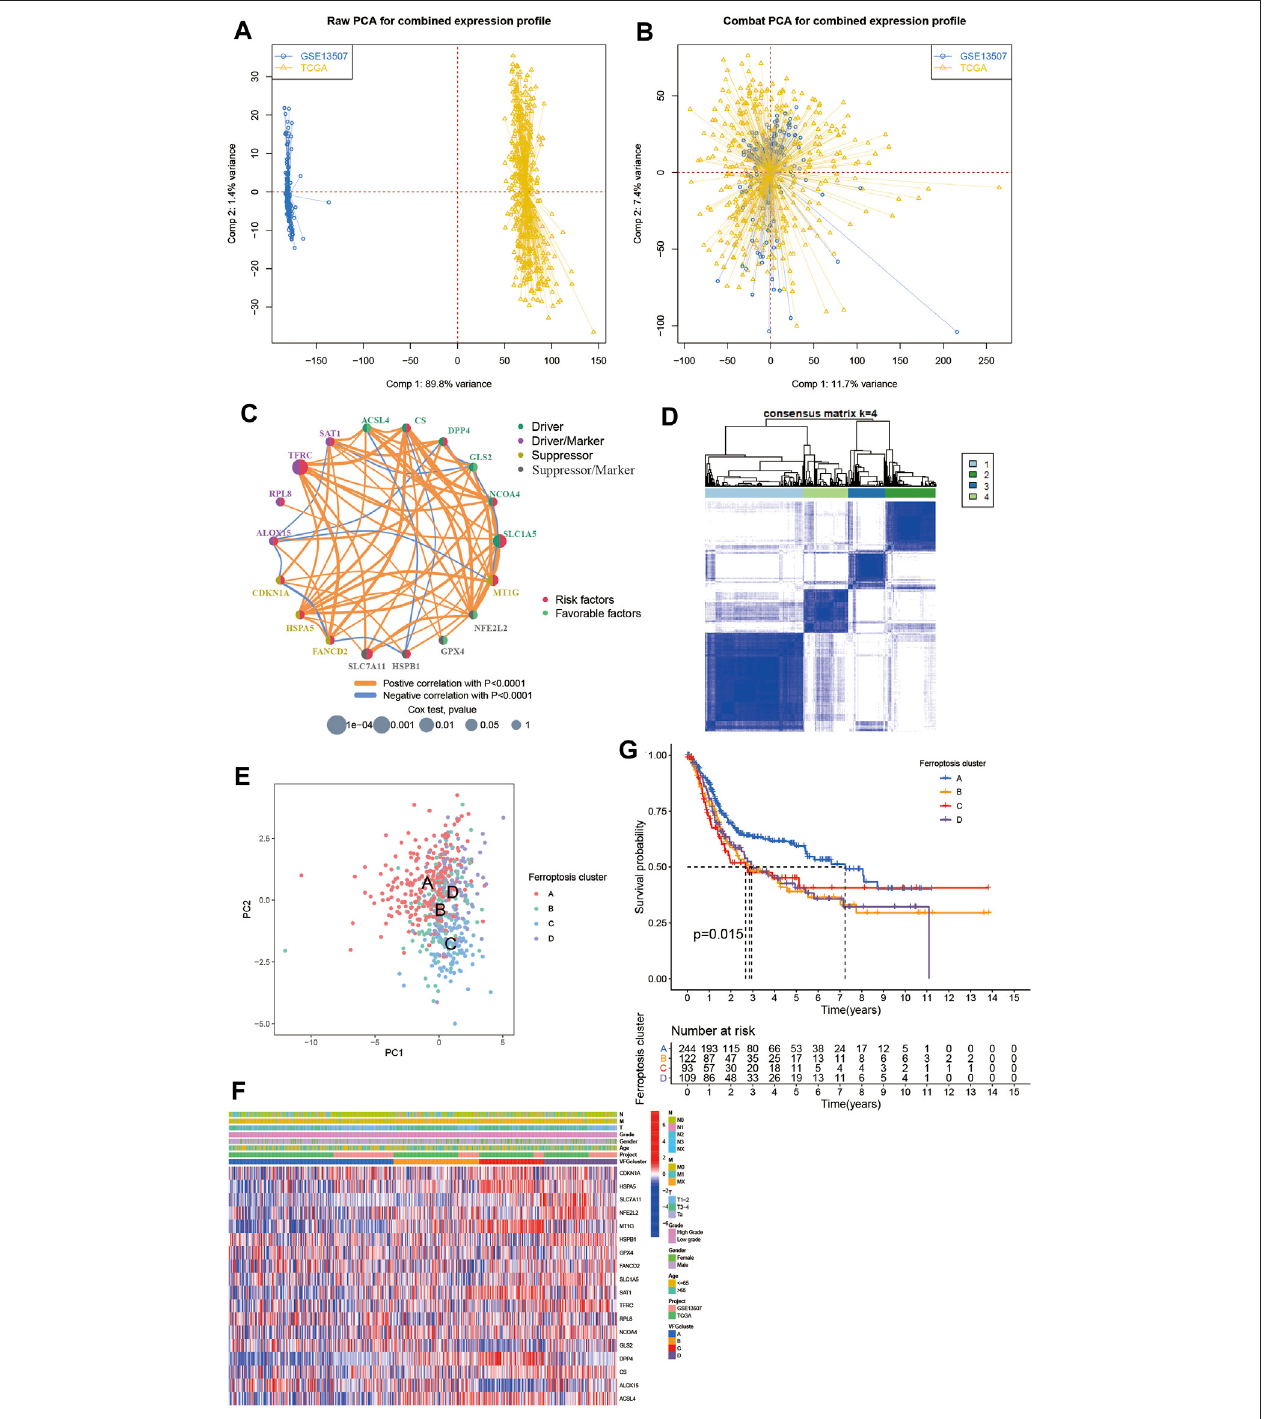
FIGURE 2 | Patterns of ferroptosis and biological characteristics of each pattern. (A,B) Principal component analysis for the expression pro fi les of common genes before and after combination of GSE13507 and the TCGA-BLCA cohort. Before processing, two subgroups without intersection were identi fi ed, indicating the GSE13507 and TCGA-BLCA samples were well distinguished based on the expression pro fi les of their common genes, while the two datasets merged together well after processing. SamplesfromGSE13507 were marked withblue andsamplesfrom TCGA-BLCA markedwith yellow. (C) Interaction betweenFRGs inBCa. The circlesizerepresented theeffectofeachferroptosisregulatorgeneontheprognosis,andtherangeofvaluescalculatedbyLog-ranktestwas p < 0.0001, p < 0.001, p < 0.01, p < 0.05 and p < 0.1, respectively. Red dots in the circle, risk factors of prognosis; Light green dots in the circle, protective factors of prognosis. The lines linking